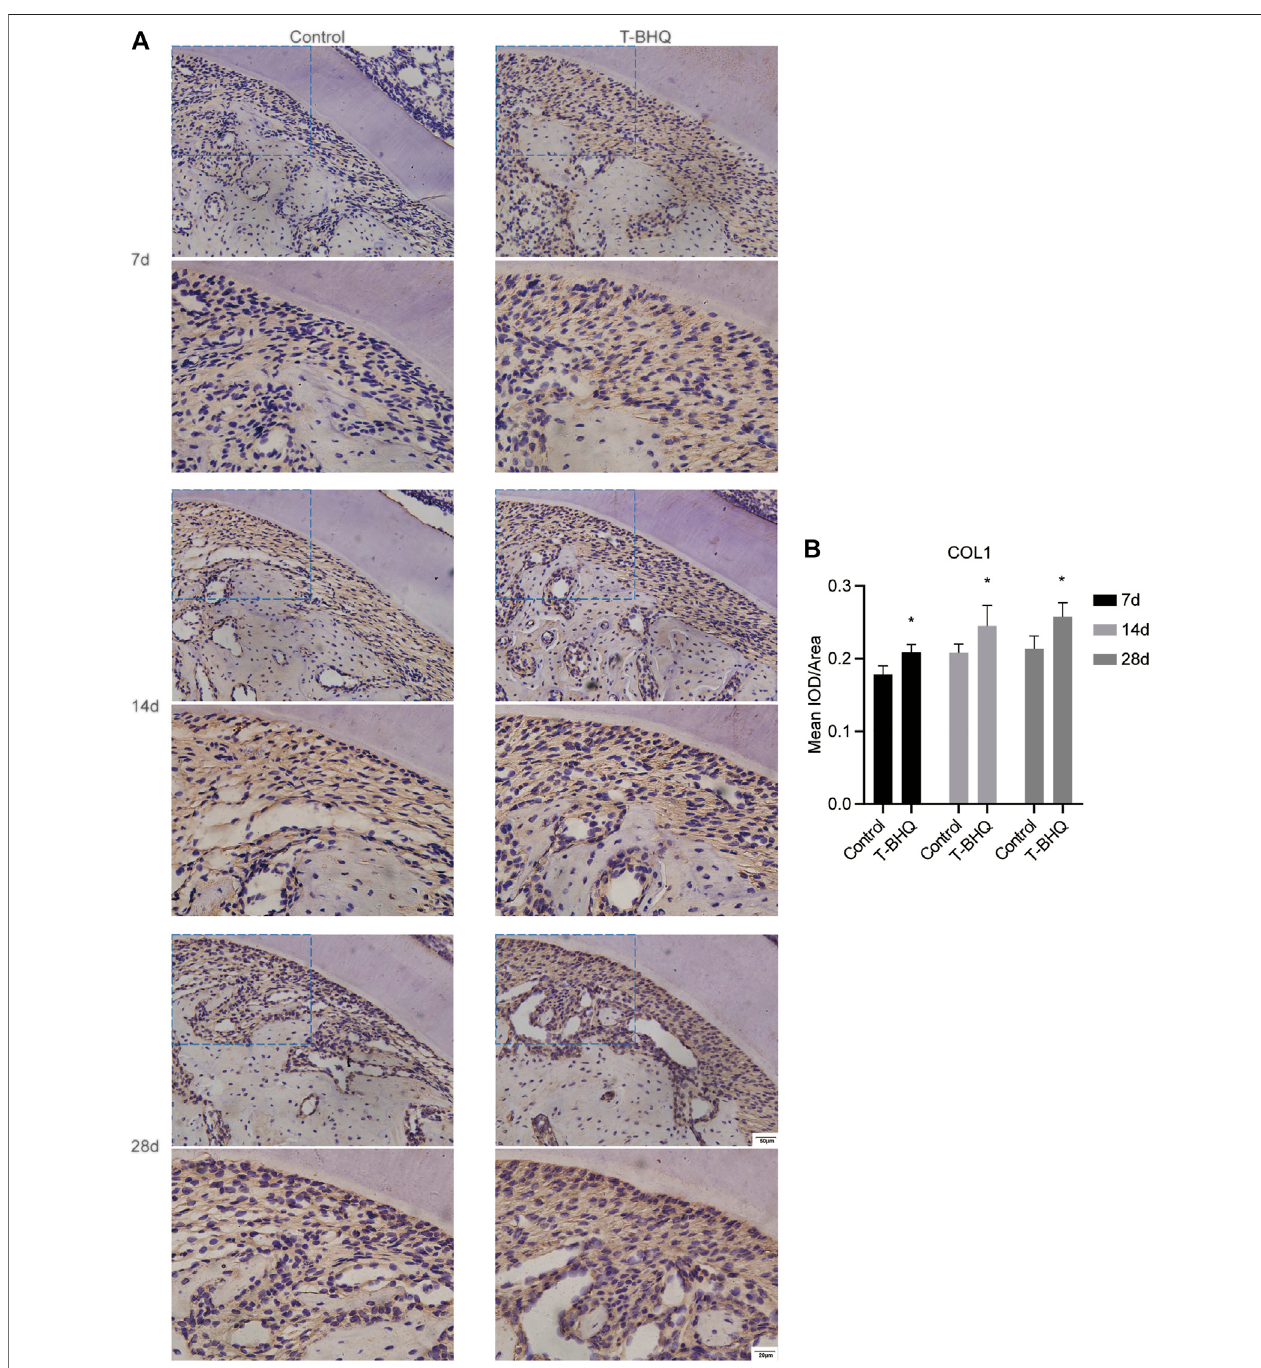
FIGURE 8 | The increased expression of COL1 in the PDL at the tension side in orthodontic rats with t-BHQ treatment. (A) The expression of COL1 was up- regulated with t-BHQ treatment in the PDL at the tension side in orthodontic rats through IHC staining. The scale bars, 20 and 50 µm. (B) The mean IOD/Area of COL1 was quanti fi ed through Image-Pro Plus 6.0 software. N (cid:1) 3 specimens in each group.